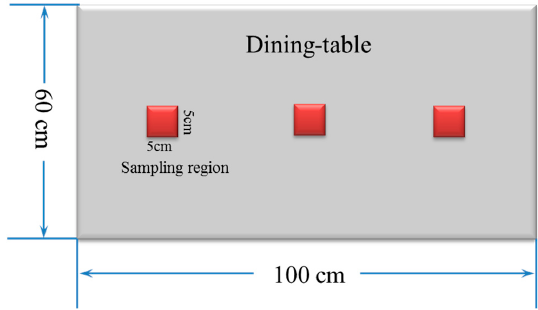
Figure 2. A sketch of a dining table and sampling regions.